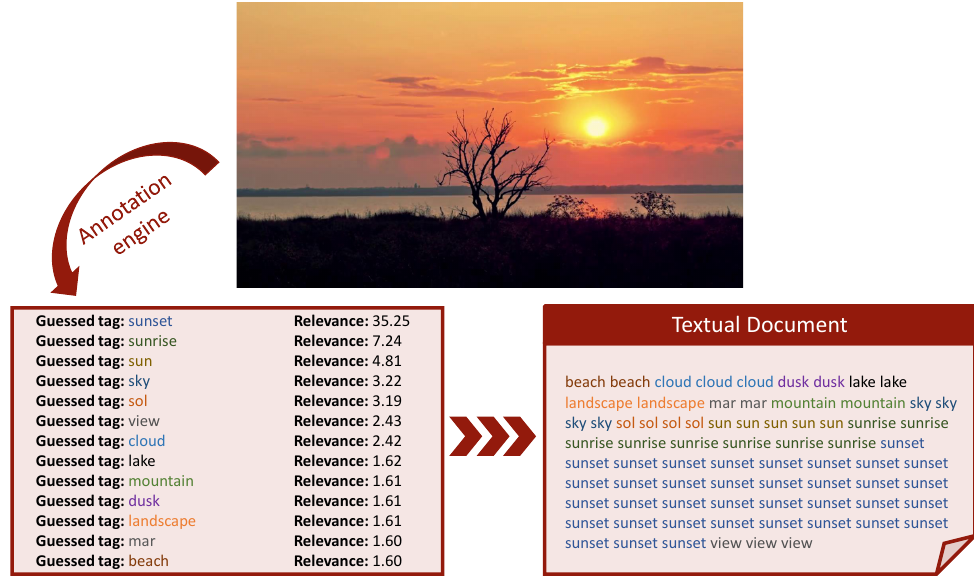
Figure 6. Example of our image annotation and its representation as single textual document. In the textual document, each tag is repeated a number of times equal to the least integer greater than or equal to the tag relevance (e.g., beach with relevance 1.60 is repeated 2